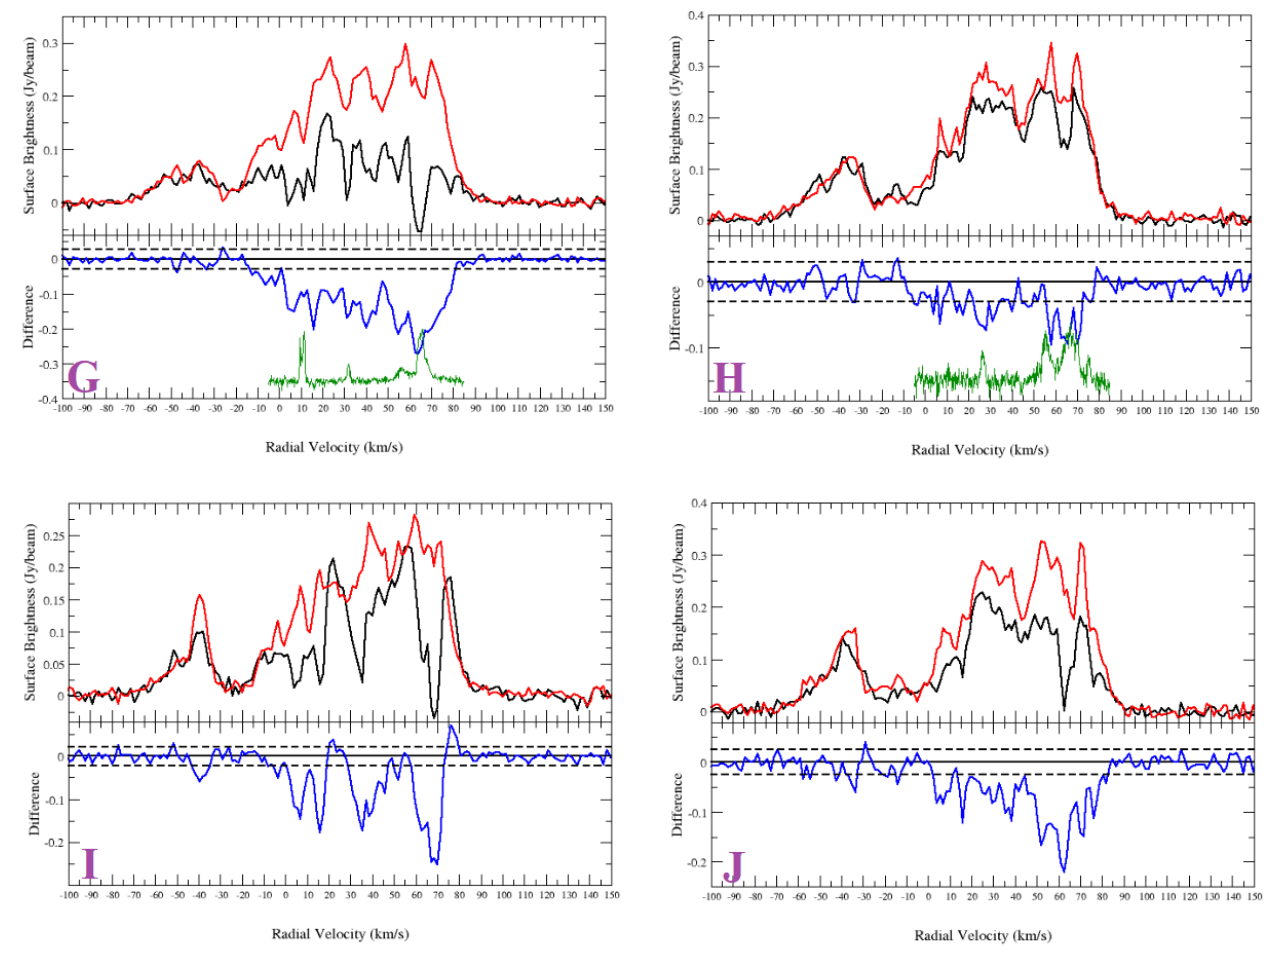
Figure A2. HI spectra of the sources from Sample 1 and nearby objects. Non-thermal sources: ( A ) G27.920 + 0.977; ( B ) G35.351 + 0.239; ( C ) G35.484 + 0.424; ( F ) G41.889 − 0.386; ( G ) G42.028 − 0.605; ( H ) G42.093 − 0.430. HII Regions (comparison sources): ( E ) G35.467 + 0.139; ( I ) G42.108 + 0.623; ( J ) G42.111 − 0.444. IR-quiet sources (comparison source): ( D ) G35.308 + 0.147. Top half of panel: HI emission spectra (source: black and background: red). Bottom half of panel: source—background (difference: blue). The dashed lines are ± 2 σ noise level of the difference. The green curves plotted in the lower halves of the panels are the 13 CO emission